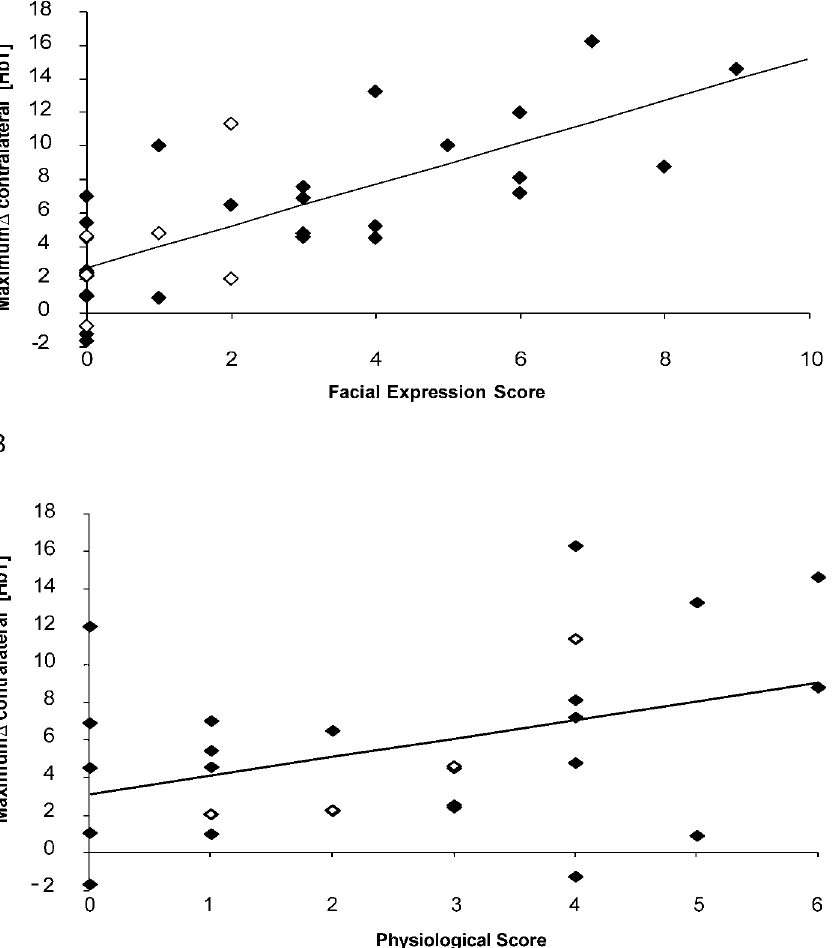
Figure 2. Relationship between the Haemodynamic Response and the Individual Components of the PIPP Score (A) Relationship between the haemodynamic response and facial expression score. Relationship between the maximum D [HbT] in the contralateral somatosensory cortex and the facial expression score. (B) Relationship between the haemodynamic response and physiological score. Relationship between maximum D [HbT] in the contralateral somatosensory cortex and the physiological response. The open diamonds represent an infant with periventricular haemorrhage